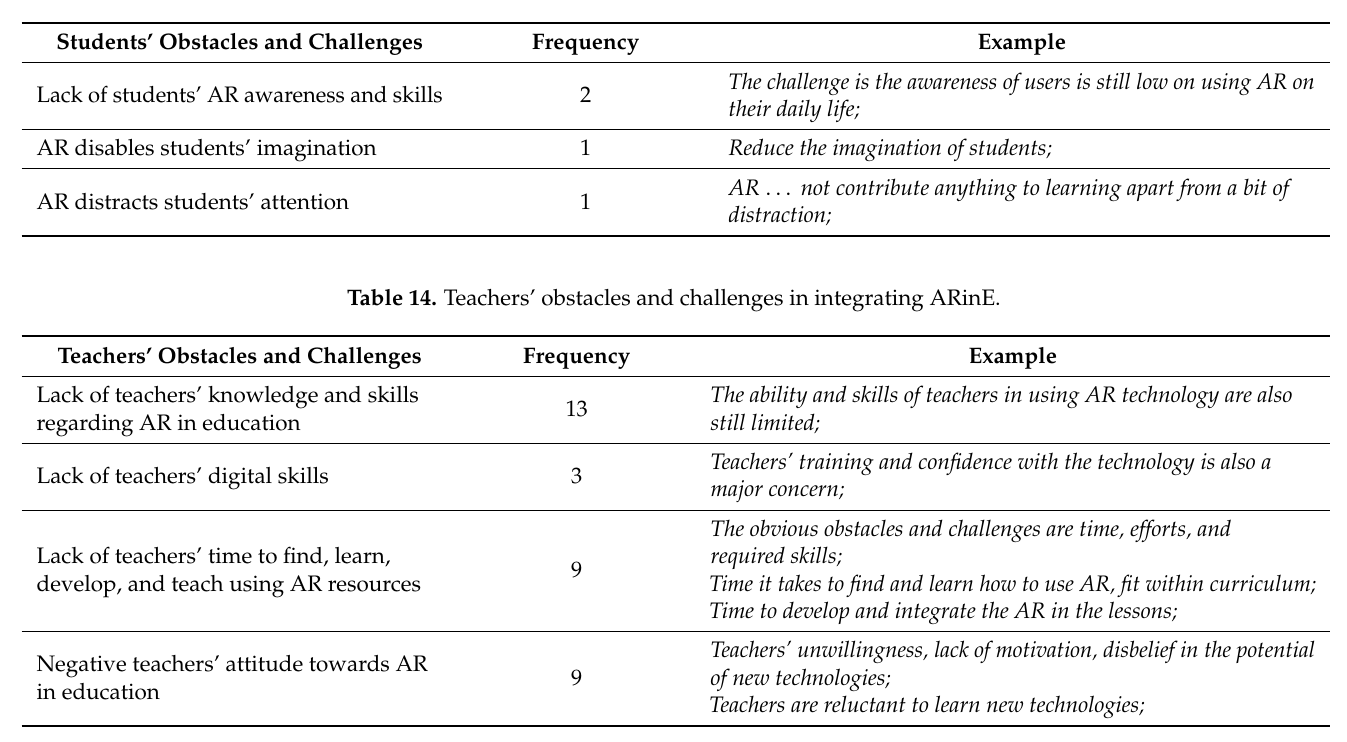
Table 13. Students’ obstacles and challenges in integrating ARinE.